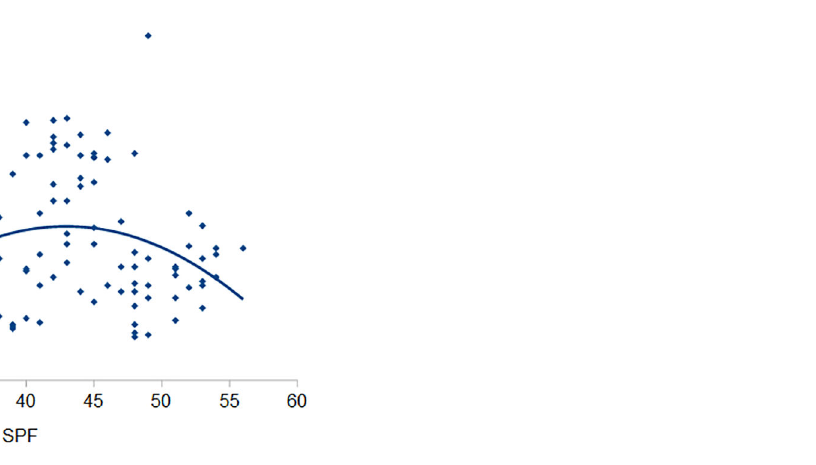
Figure 1. A scatterplot comparing self-reported empathy (SPF) and self-reported everyday creativity (CBI), which shows a curvilinear relationship ( N =